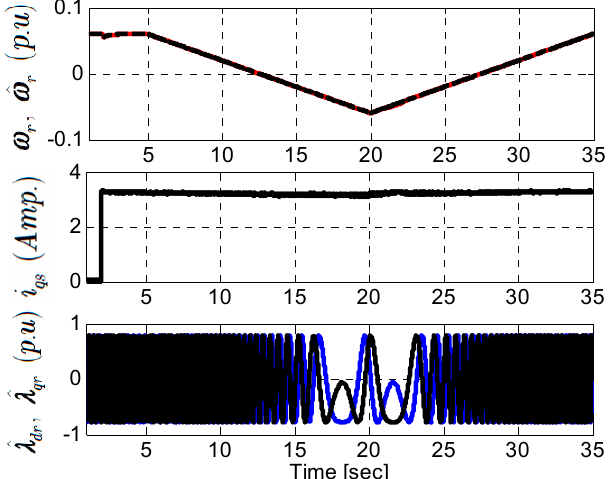
Figure 17. Simulation tests at a speed reference of 0.06 p.u (9.42 rad/s) was changed slowly to − 0.06 p.u ( − 9.42 rad/s) with an applied T L change of +7 N.m applied at t = 2 s.